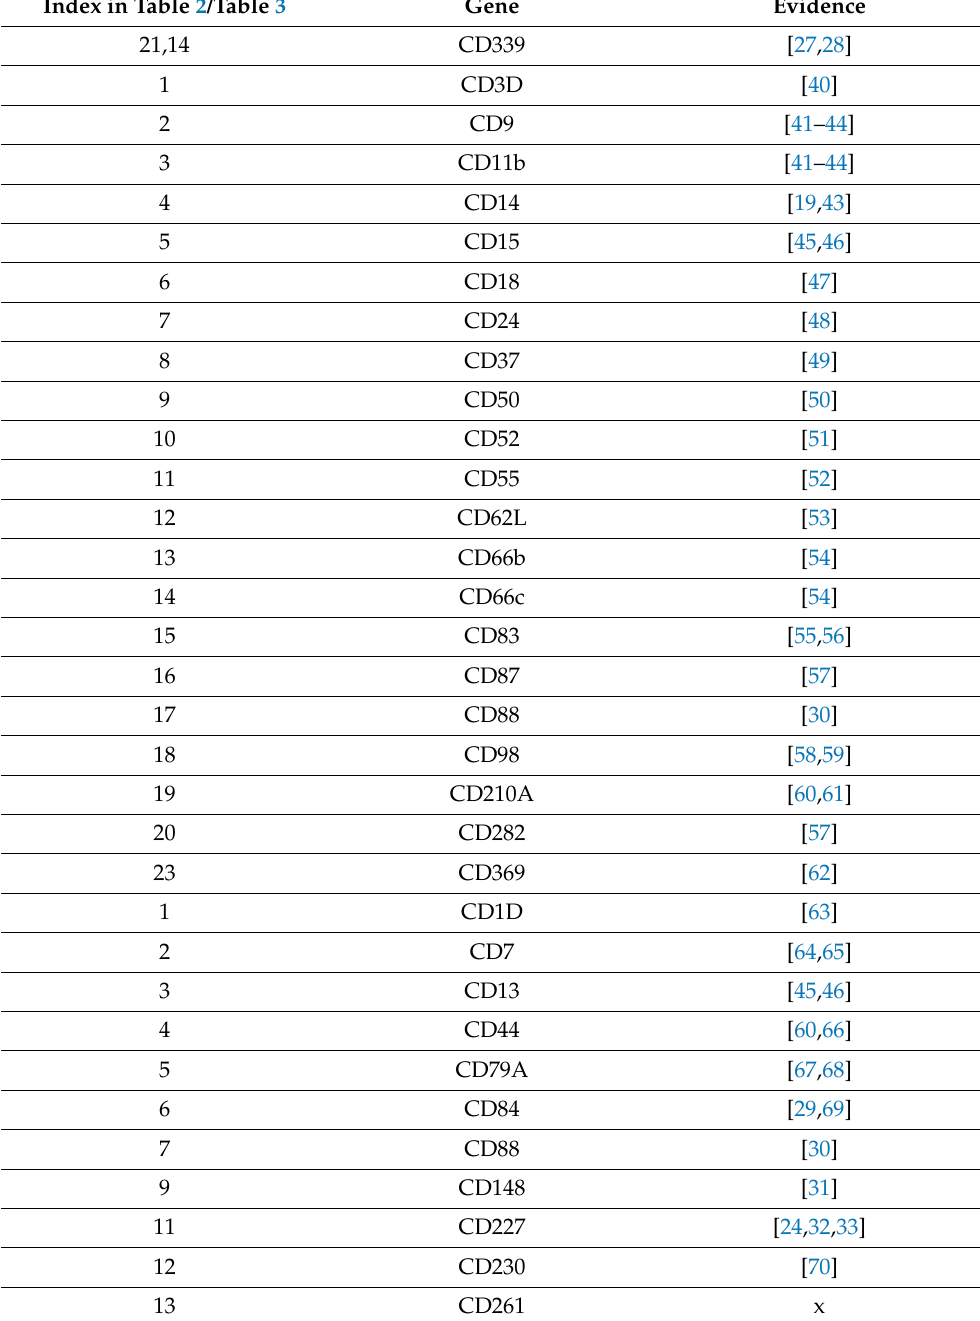
Table 5. Supporting evidence from the literature for differential expression of CD genes in APL and other AML subtypes. If differential expression could not be deduced from previous reports, references describing expression in AML are